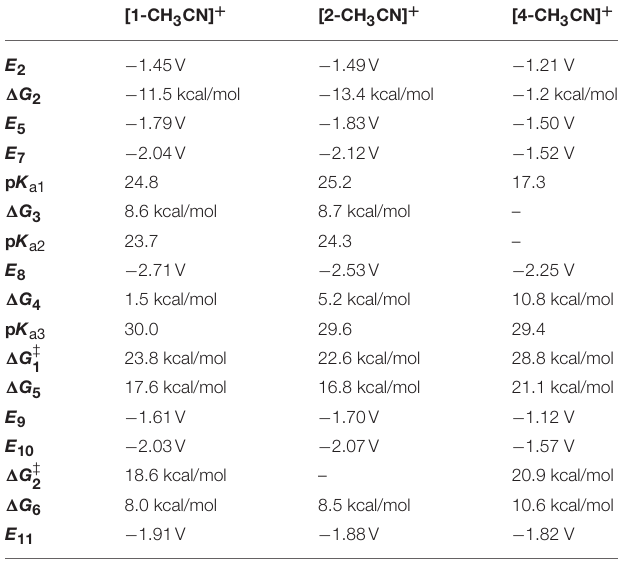
TABLE 6 | Computed reduction potentials (V vs. Fc + / 0 ), free energy changes ( 1 G , kcal/mol) and activation free energies ( 1 G ‡ , kcal/mol), and p K a ’s relevant for electrocatalytic reduction of CO 2 to CO for Mn I polypyridyl complexes [1-CH 3 CN] + , [2-CH 3 CN] + , and [4-CH 3 CN] + , shown in Scheme 2 , comparing the protonation-first and reduction-first pathways vs. the three-electron